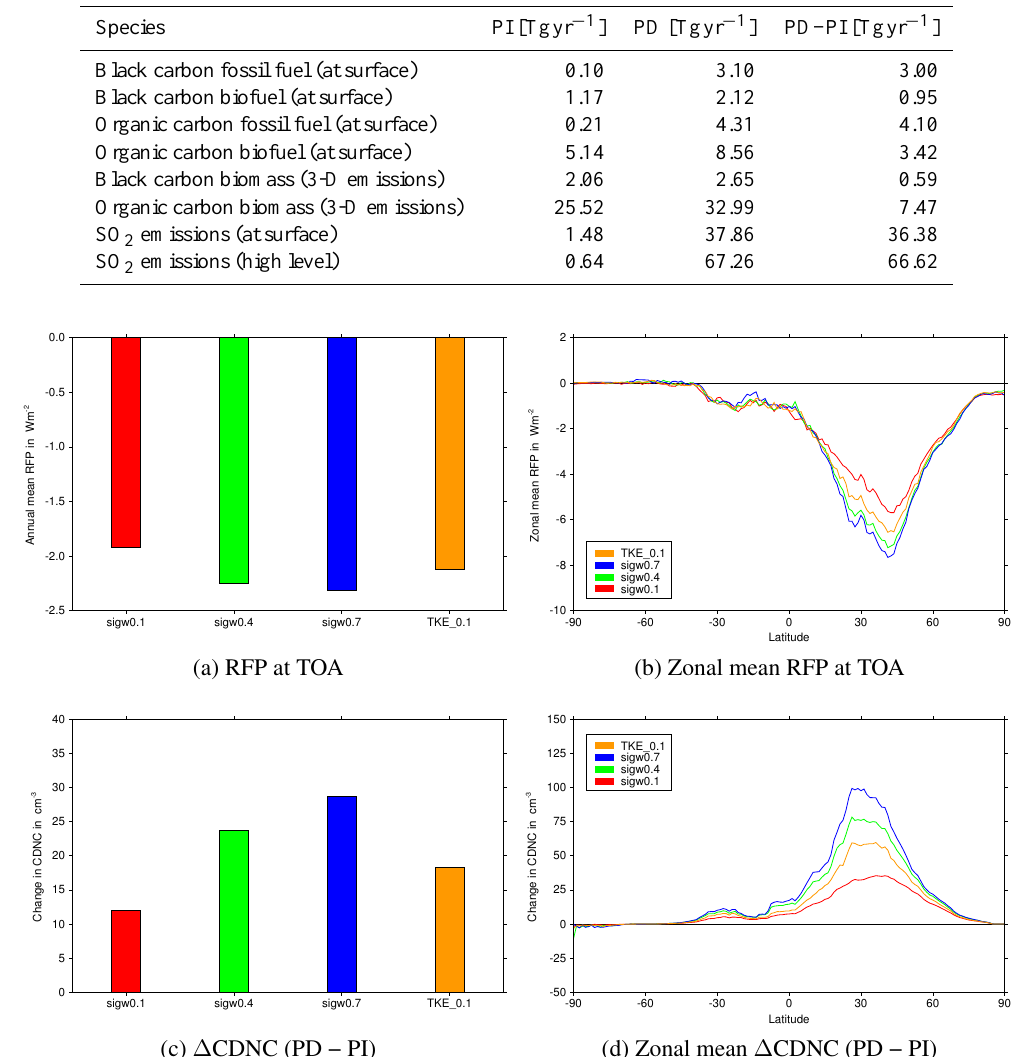
Figure 8. RFP due to total anthropogenic aerosol effects and change in annual mean CDNC (at 720m) for model configurations sigw0.1 (red), sigw0.4 (green), sigw0.7 (blue) and TKE_0.1 (orange). (a) and (c) show differences in global mean (PD − PI); (b) and (d) show differences in zonal mean (PD − PI).